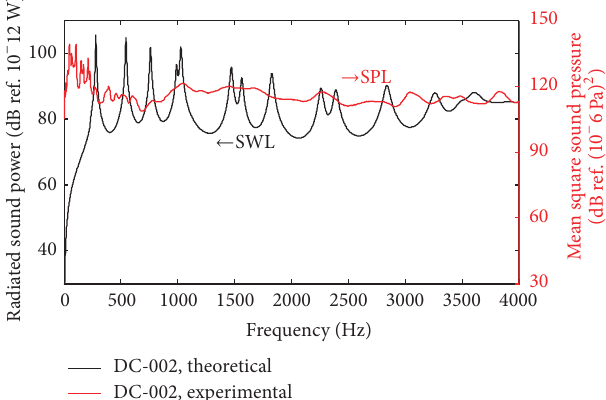
Figure 10: Comparison of theoretical and experimental sound fields.